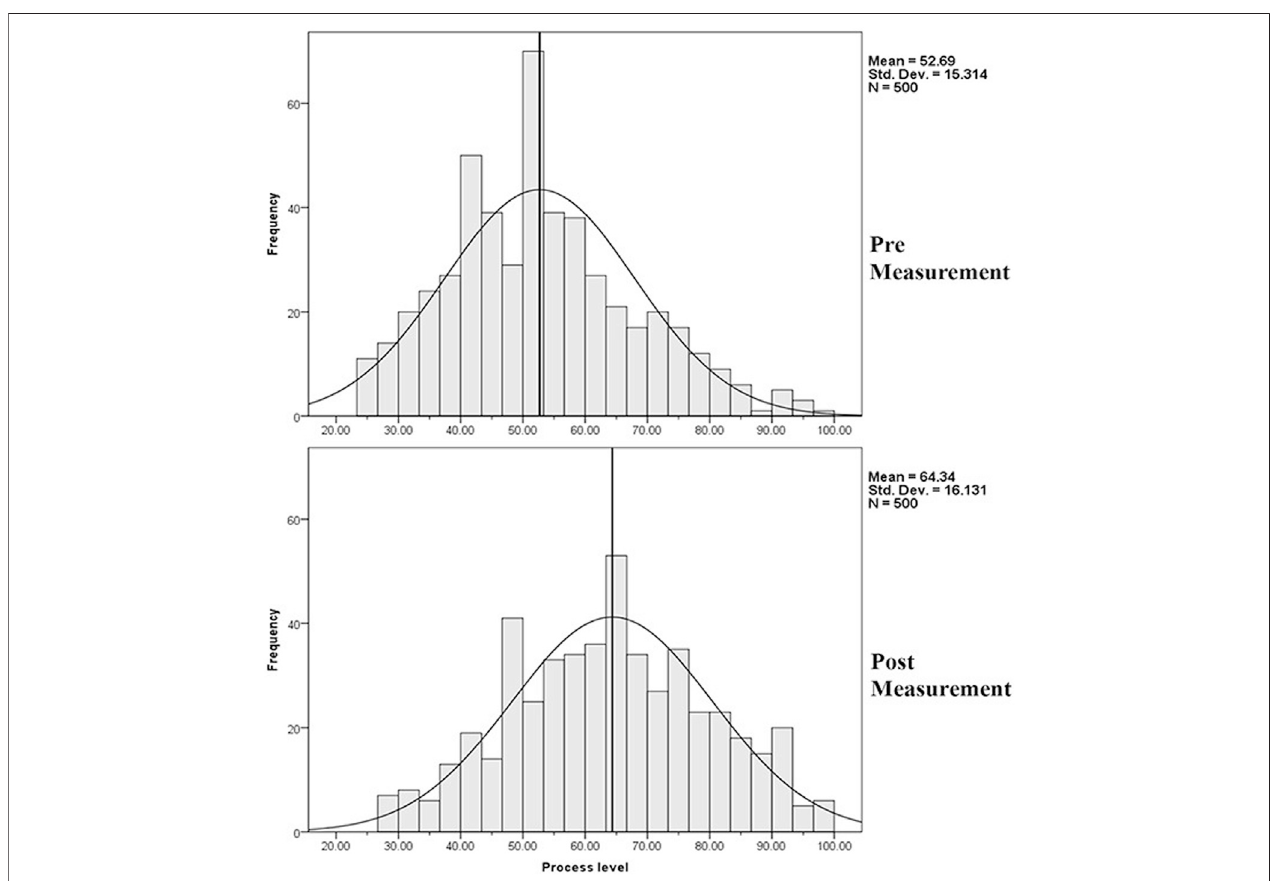
FIGURE4| Frequenciesoftheschoolscoresintheprocesslevel.Inthegrapharepresentedtheresultsfromthepre-andthepost-measurements.Theverticalline illustrates the mean value of school scores.